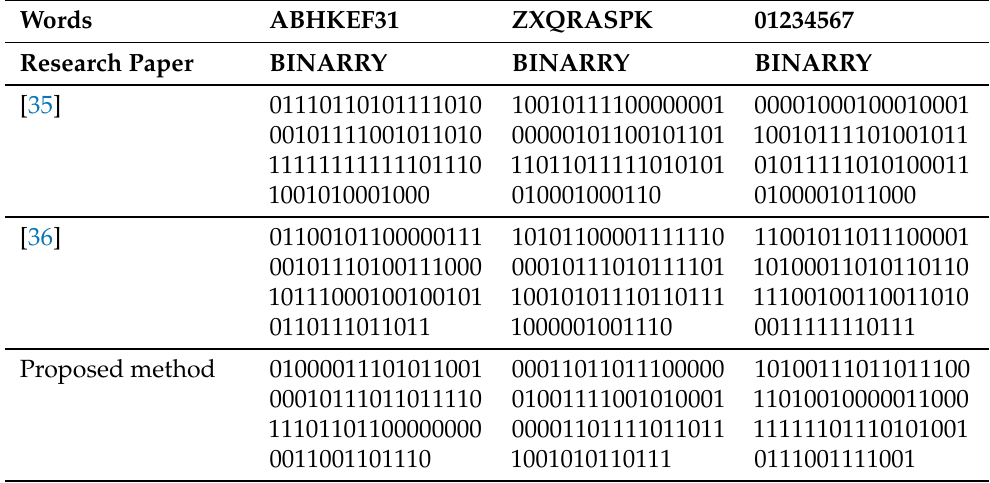
Table 5. Comparison between the proposed method and the previous works for the binary output of S-Boxes to compute balanced criteria.